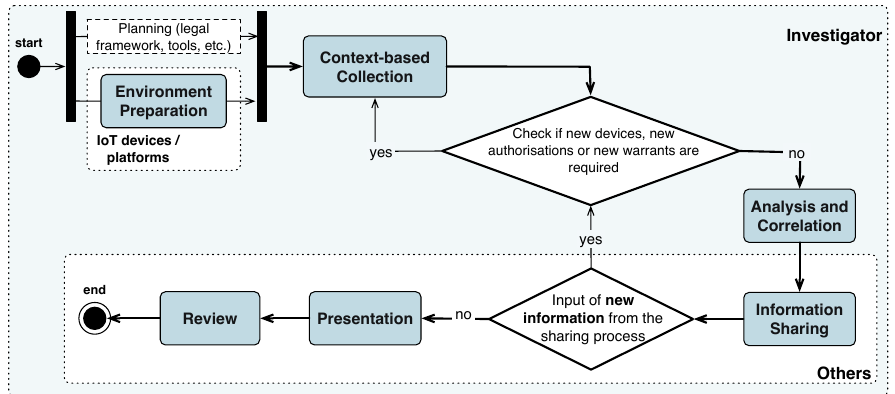
Figure 3. The PRoFIT model [4].